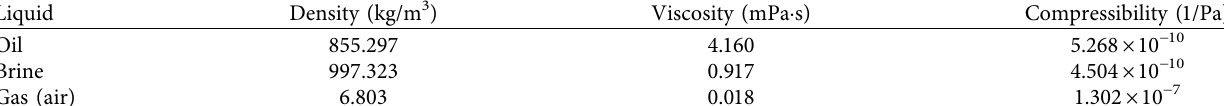
Table1: Properties of fluids used in microfluidic visualization experiments (24.3 ° C, 99.2kPa).